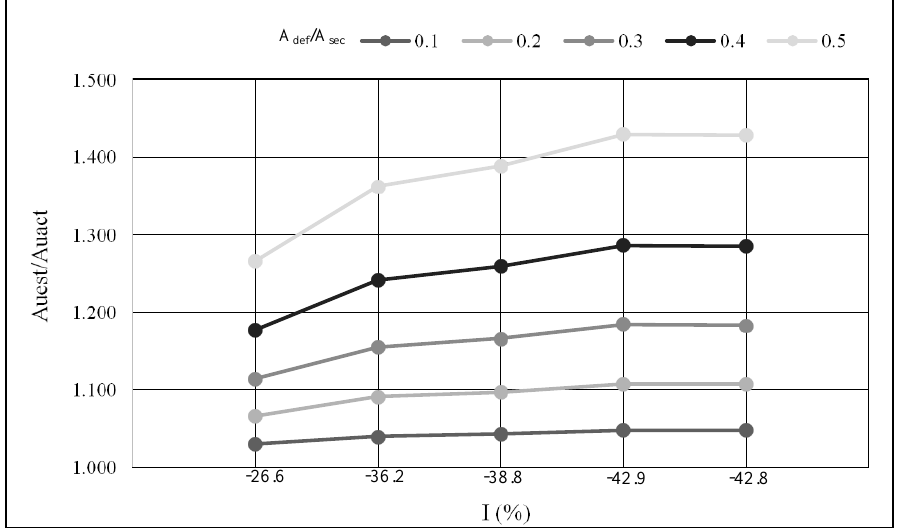
Figure 16. Ratio between the estimated area of the usable cross section Au est and the actual area of the usable cross section Au act . A def and A sec are the area of the cross section of the defect and of the element, respectively.